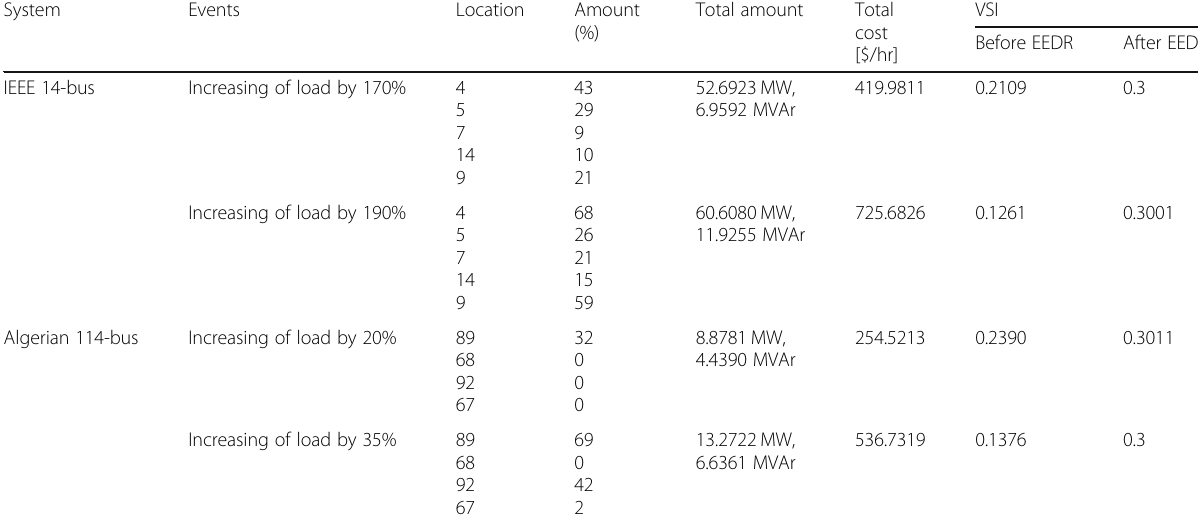
Table 4 EEDR results in IEEE 14-bus and Algerian 114-bus systems in the case of load increasing System Events Location Amount